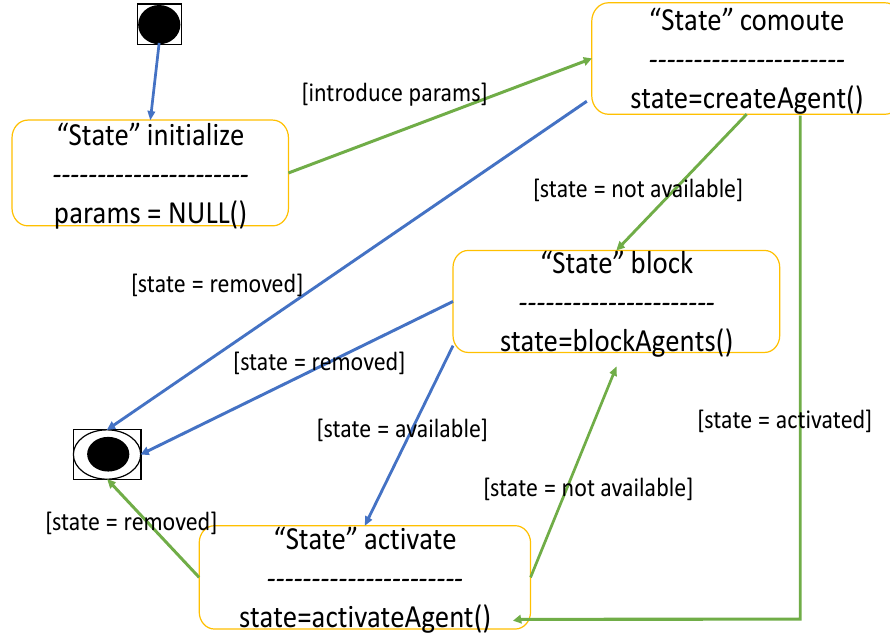
Figure 9. Model of “the satisfaction plan” for the goal “managing agents”.